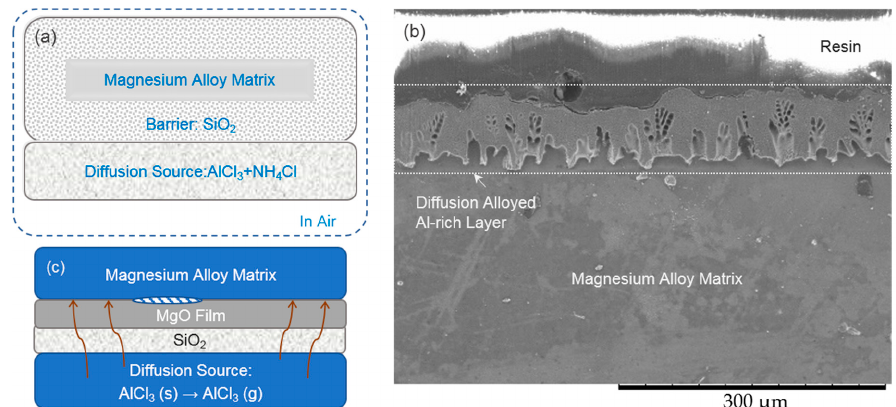
Figure 6. ( a ) The illustration of the di ff usion alloying system to prove the existence of vapor transport; 6 ( b ) The as-di ff usion alloyed intermetallic layer utilizing the di ff usion alloying system shown in ( a ); ( c ) The source and movement of the AlCl 3 gas which carrying active Al